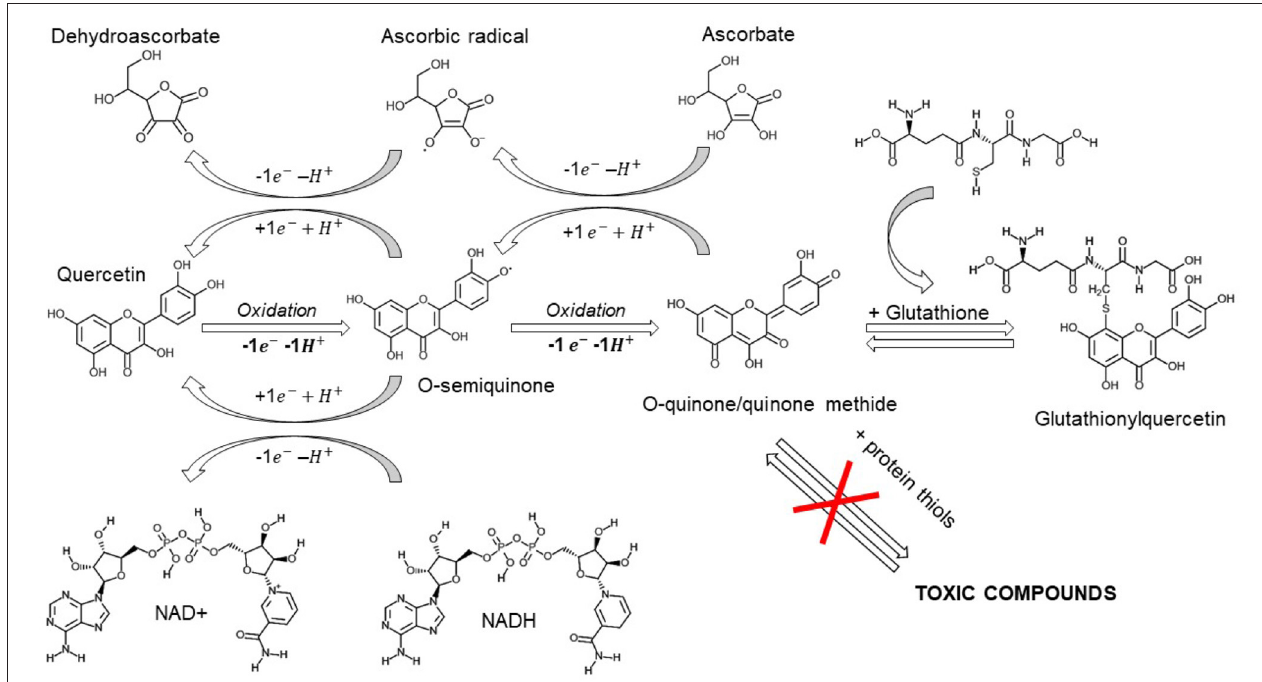
FIGURE 2 | After exerting its scavenging properties, quercetin is oxidized into its reactive products o-semiquinone and o-quinone/quinone methide (QQ). These compounds can be recycled by antioxidants like ascorbate or NADH or removed by glutathione. If ascorbate or glutathione levels are reduced, QQ can bind protein thiols producing transient toxic compounds. Created with ChemDoodle Web with permission (18).